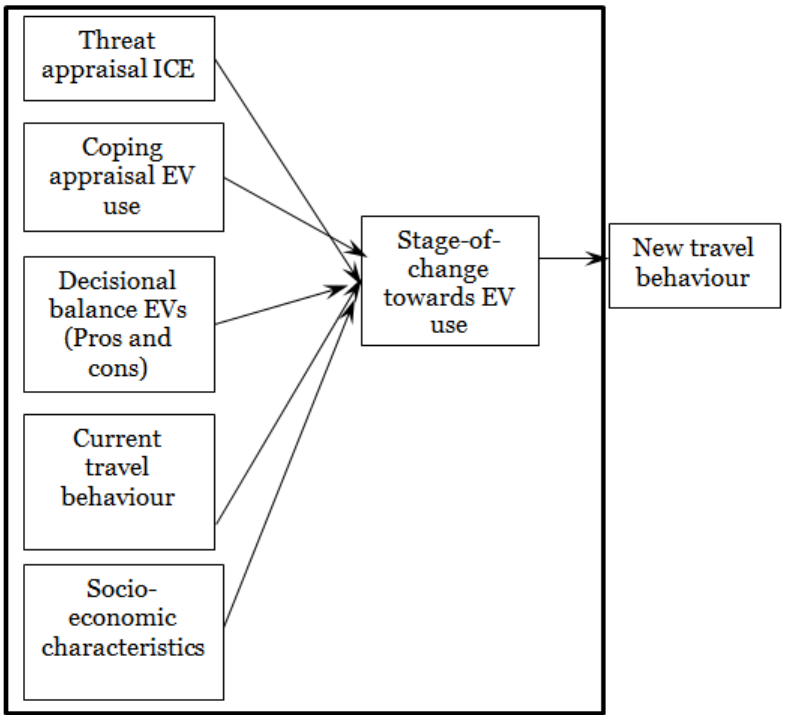
Figure 1. Conceptual framework influencing factors stage-of-change towards EV